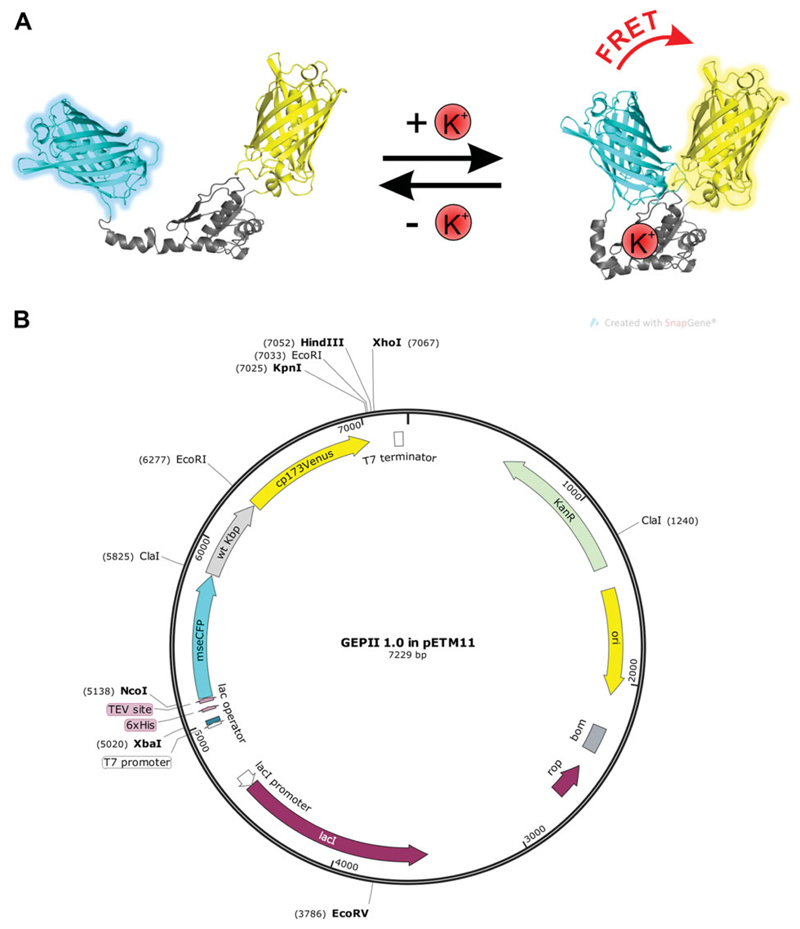
Functional principle and plasmid map of GEPII 1.0. (A) Schematic
representation of the K+-sensing mechanism of GEPII 1.0. mseCFP
(cyan), wild-type Kbp (grey), and circularly permuted Venus (yellow) are shown.
(B) Plasmid map of GEPII 1.0 subcloned into pETM11 vector for
bacterial expression. mseCFP (cyan), wild-type Kbp (wt Kbp, grey), and
circularly permuted Venus (cp173Vens, yellow) as well as the most important
features of the plasmid are indicated in the map. Single-cutting restriction
enzymes (EcoRV, HindIII, KpnI
NcoI, XbaI, and XhoI, all
in bold) as well as internal restriction sites with multiple cutting sites
(ClaI and EcoRI) are indicated. Locations
of the 6× His-Tag and a TEV protease site located between the His-Tag and
mseCFP are shown.